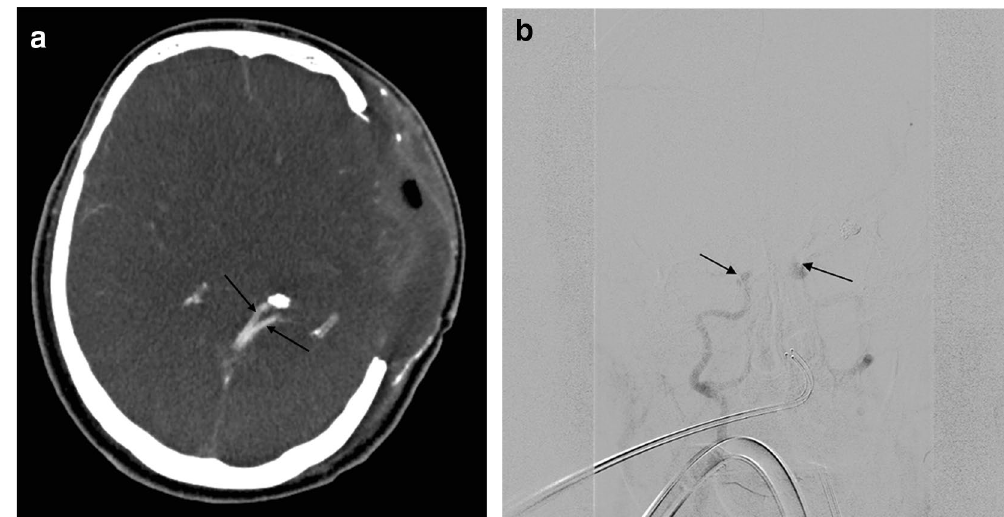
Figure 4. ( a ) Axial CTA (60 s phase), shows opacification of both internal cerebral veins (black arrows) in a craniectomy patient. ( b ) Digital Subtraction Angiography of the same patient in late phase (AP view), shows stasis filling on both cavernous ICAs (black arrows), with no venous